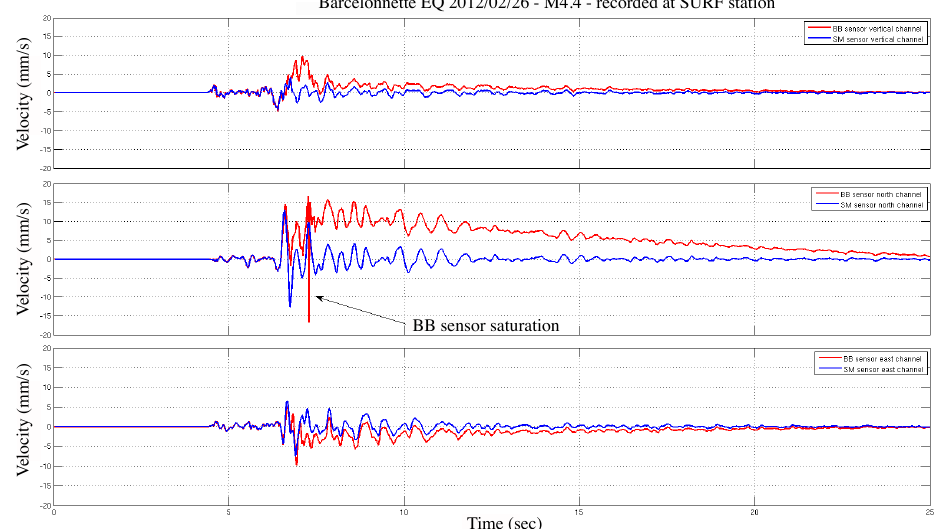
Fig. 2. Accelerometer (blue) and broadband seismometer (red) recordings of the Barcelonette Mag 4.4 earthquake, located 10km away SURF station. All traces converted to velocity.